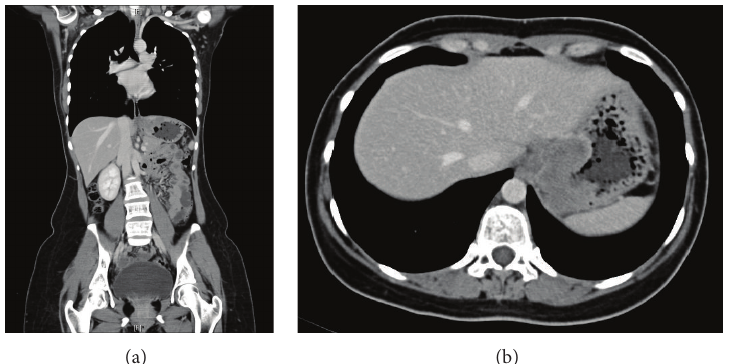
Figure 1: Coronal (a) and transverse (b) chest, abdominal, and pelvic contrast-enhanced computed tomography (CT) scans: showing a 3.8 × 7.2 × 8.7cm ill-defined mass, involving gastric fundus and extending into gastric cardia and lower gastroesophageal junction. It was associated with multiple enlarged gastrohepatic lymph nodes. There was no evidence of ascites or retroperitoneal or mesenteric lymphatic